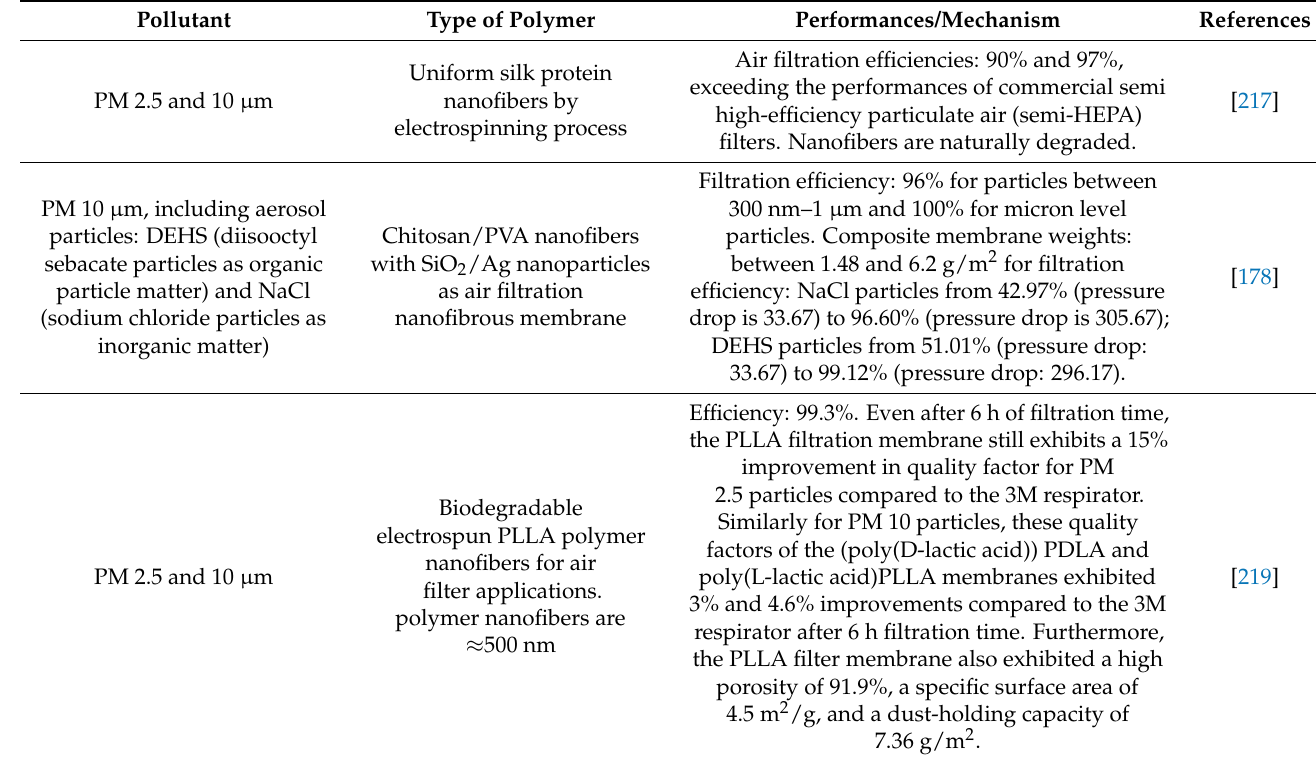
Table 4. Main performances of natural polymers as filtration substrates for air